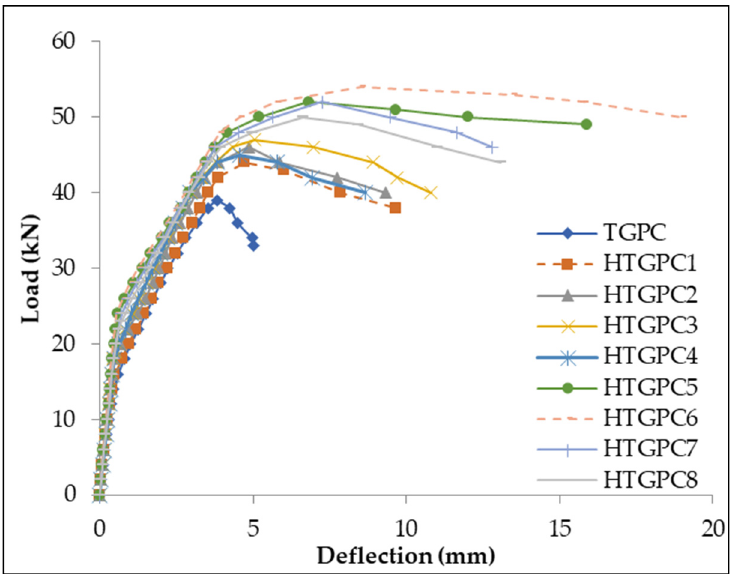
Figure 4. Load versus deflection